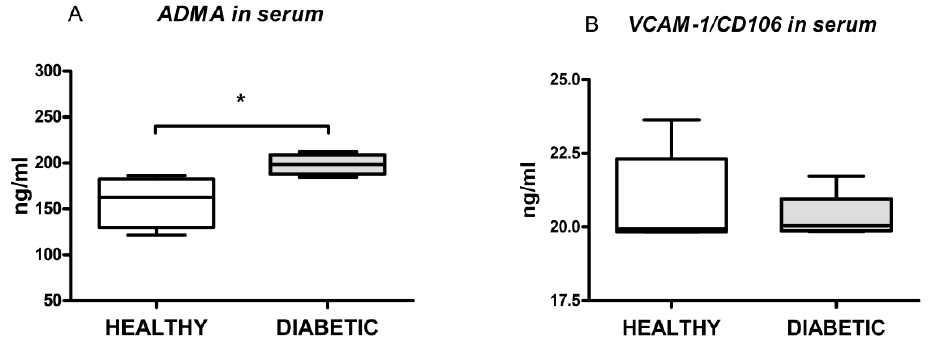
Figure 4. Box and whiskers plots showing serum levels of asymmetric dimethylarginine (ADMA) and vascular cell adhesion protein-1/cluster of differentiation 106 (VCAM-1/CD160) in healthy and diabetic animals. The upper and the lower hinge of the boxes represent the interquartile range, the midline represents the median value, and the whiskers represent maximum and minimum values. * p < 0.05. Table 1. Adenosine-induced relaxation in isolated rat femoral artery obtained from different animal groups/subgroups in the presence or absence of KCl (100 mM).